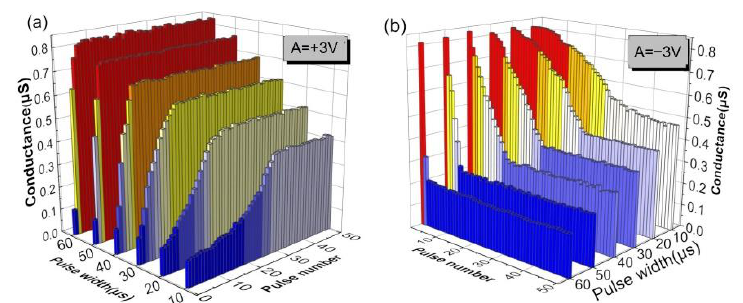
Figure 8. Conductance tunability upon pulse width during ( a ) potentiation and ( b ) depression for the NP-embedded devices.